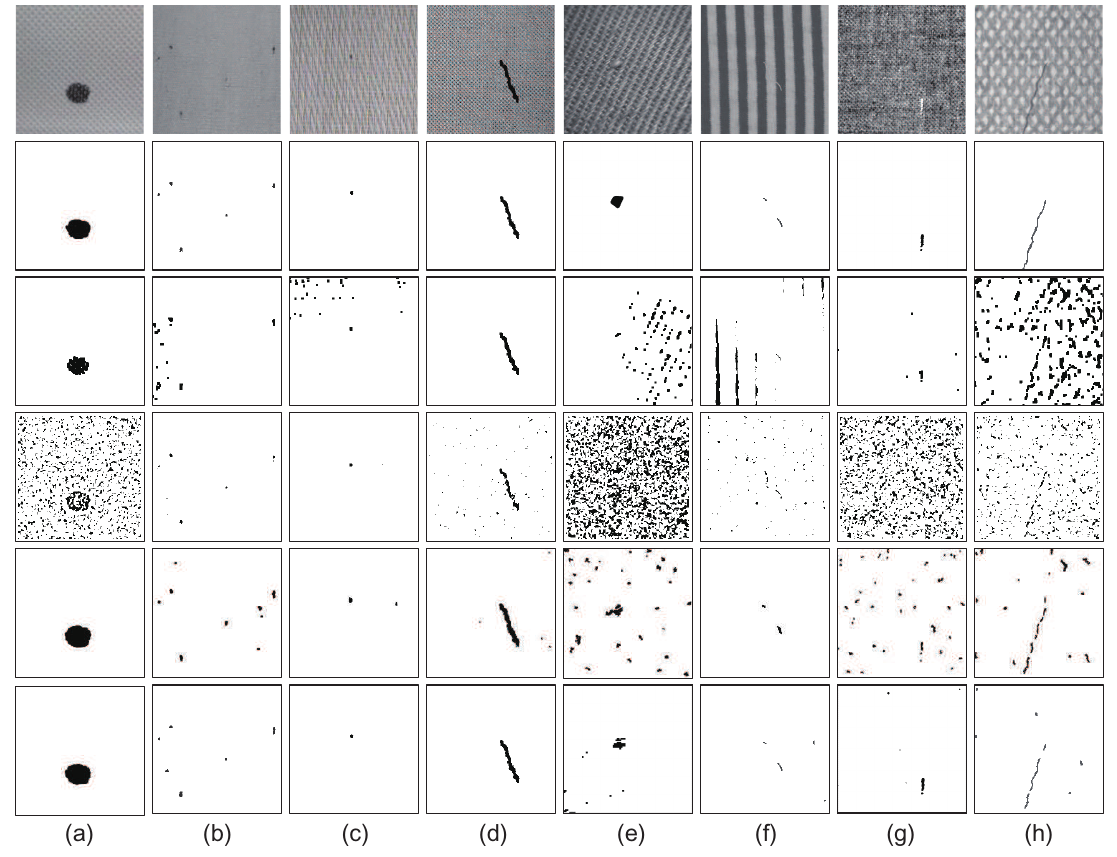
Figure 11. Defect detection results obtained with different methods for various textural samples. Top to bottom are the original defective samples, ground-truth regions, and results obtained by the DCT, PHOT, NLSR and MSCDAE models. Defects ( a ) to ( h ) are representative samples in each sample